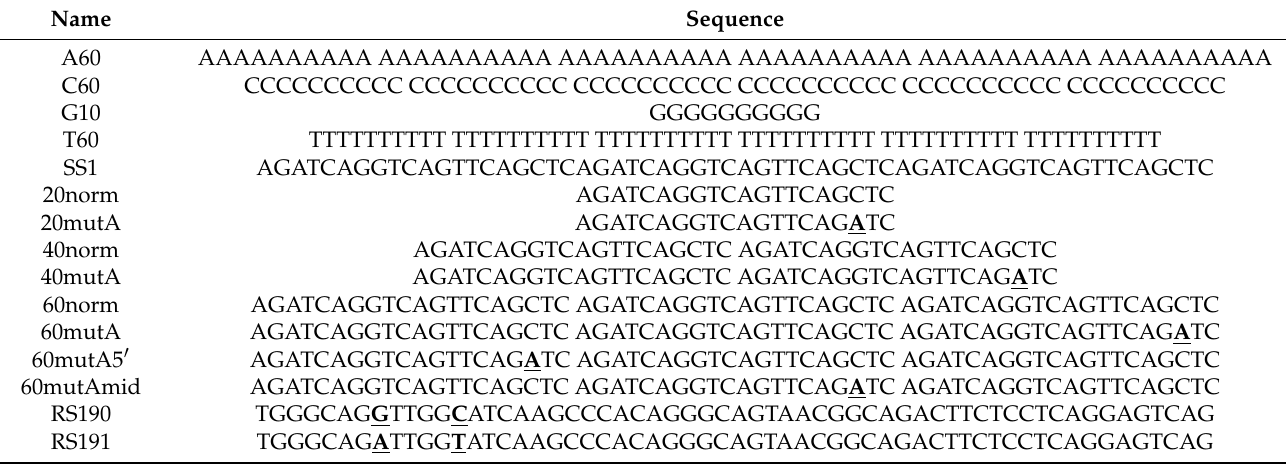
Table 1. Oligonucleotide sequence used in the